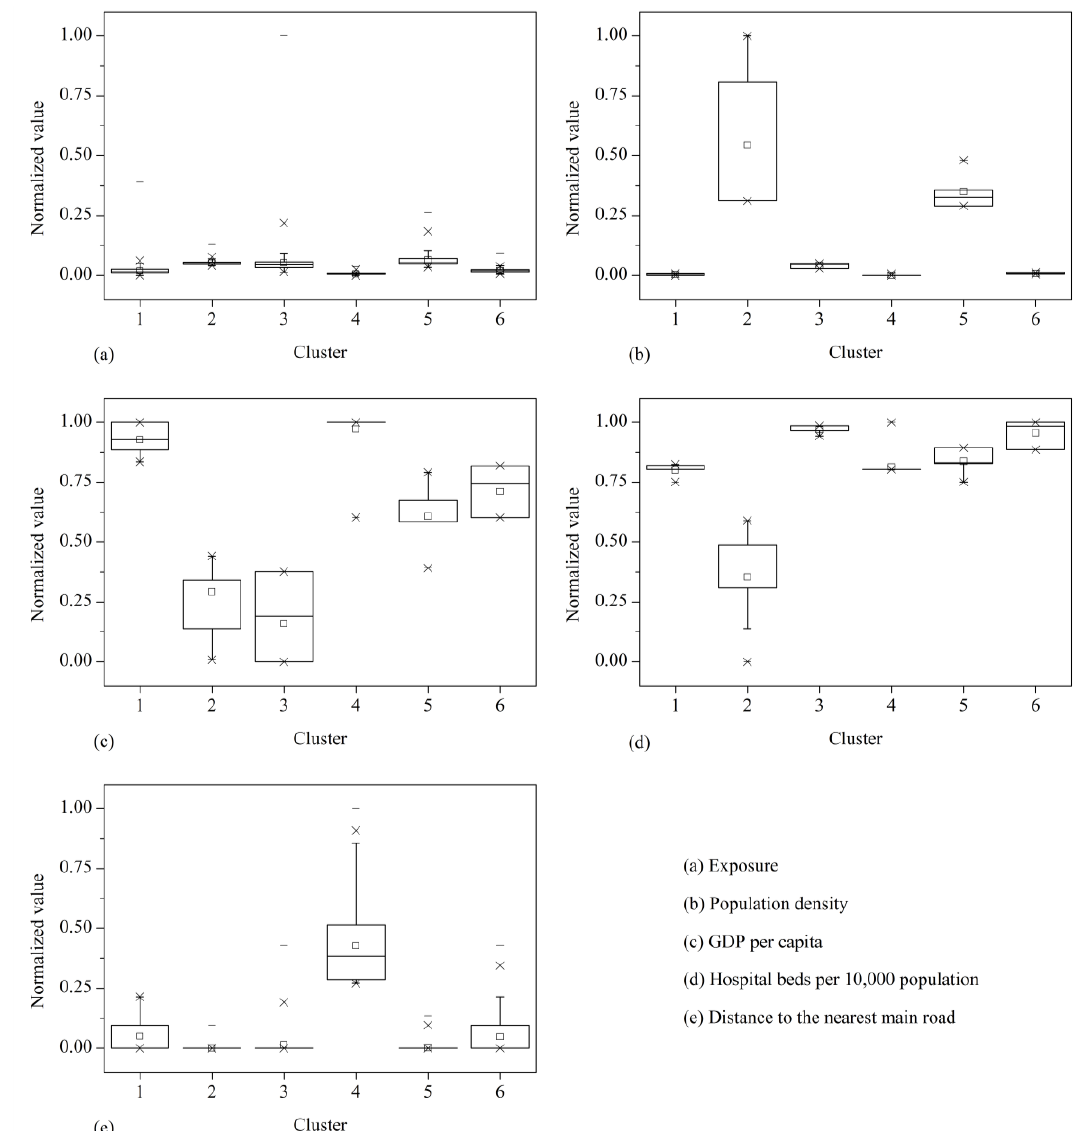
Figure 6. Box plots of vulnerability indicators against